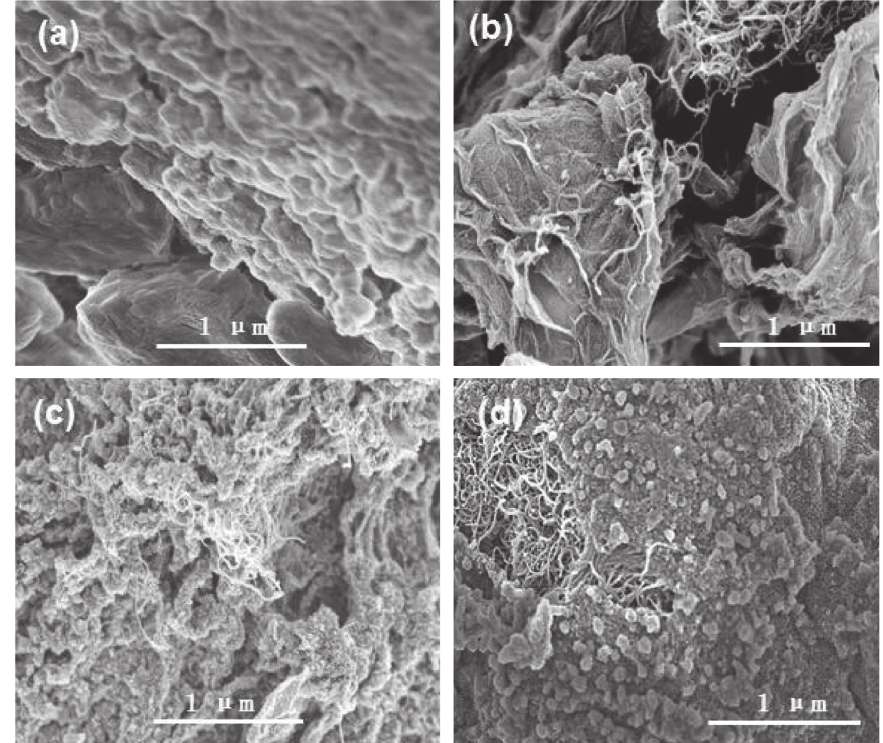
Figure 4: SEM images of (a) LiOH · H